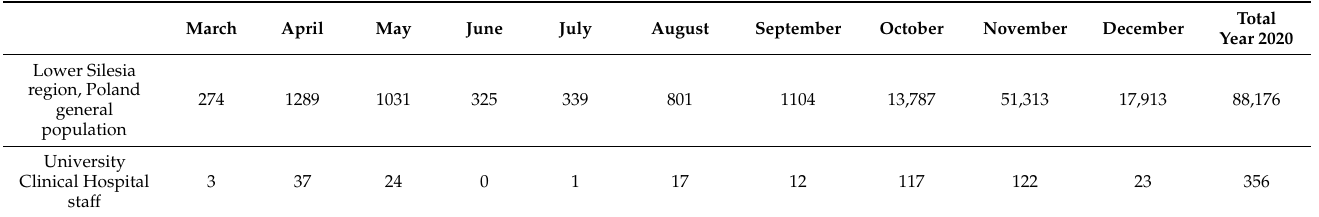
Table 1. Monthly number of new SARS-CoV-2 infections among the Lower Silesia region population [6] and among